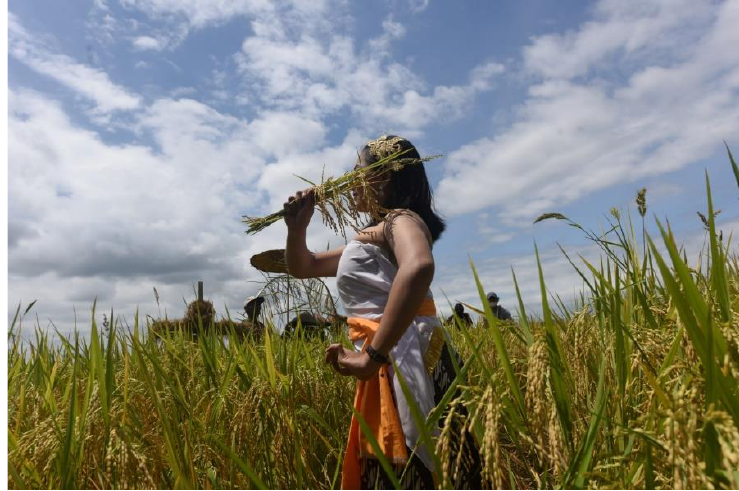
Fig. 1 . The dancers of Tayub performs in rice field. (Credit photo: Ade